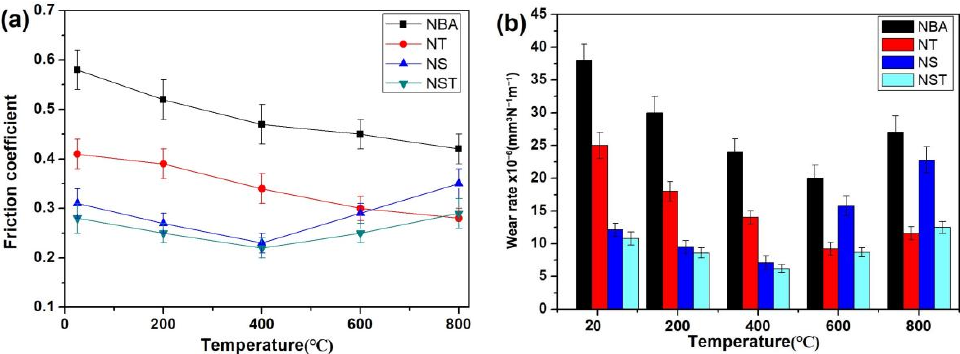
Figure 4. Friction coefficients ( a ) and wear rates ( b ) of NBA, NS, NT and NST at 20, 200, 400, 600 and 800 °C.